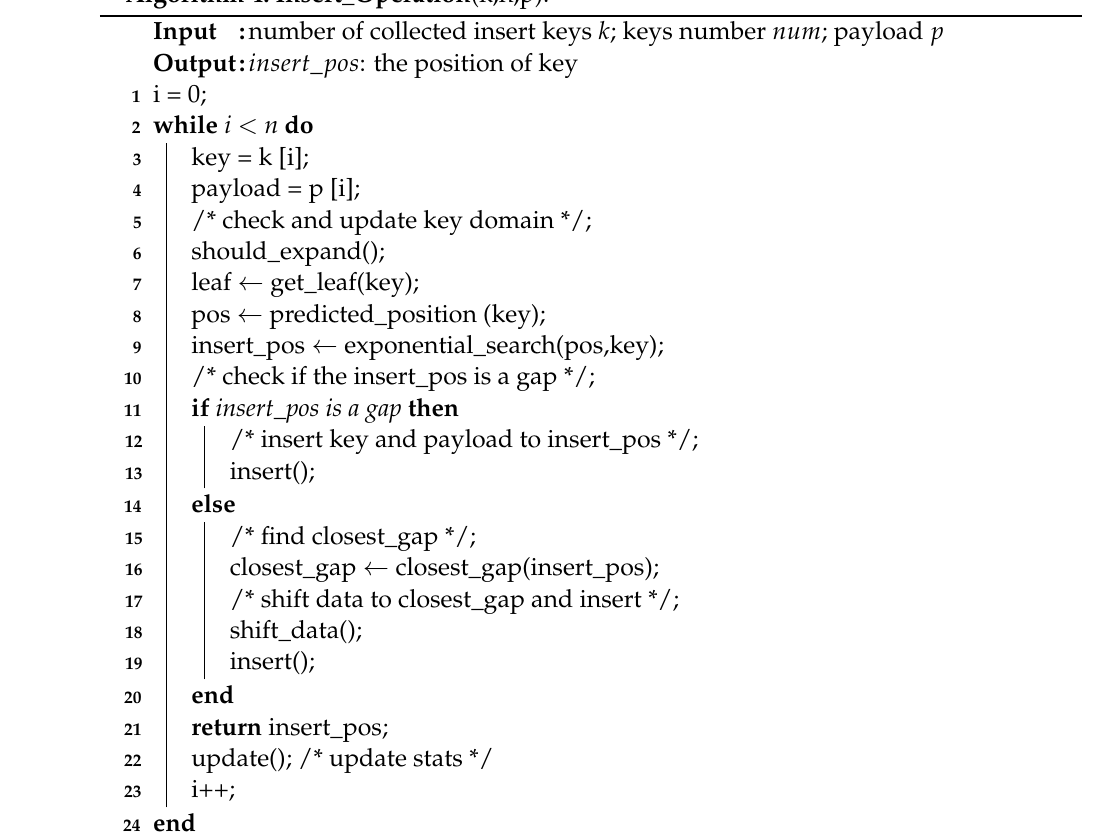
Algorithm 4: Insert_Operation